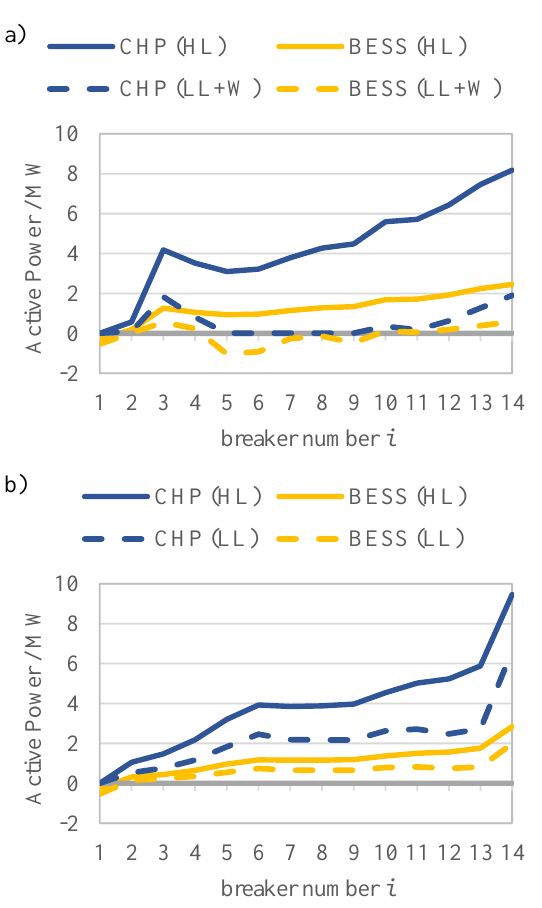
Fig. 5. Simulation results of the load flow calculations: Active power feed-in of the CHP and BESS for two strategies and two scenarios HL (Heavy Load) and LL (Low Load) However, with an appropriate control scheme of the BESS, where the load increase is balanced in the first seconds and handed over to the CHP plant slowly, this strategy would theoretically be possible to